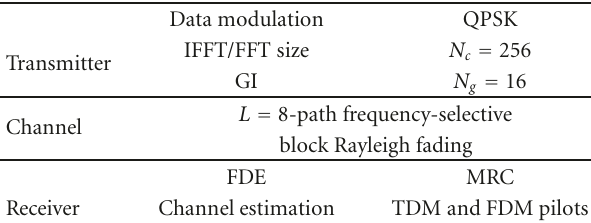
Table 1: Numerical